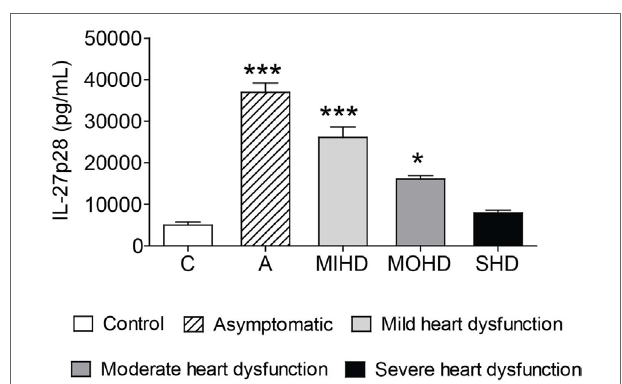
FigUre 9 | Increased serum levels of IL-27 are related to milder clinical forms of chronic chagasic cardiomyopathy. IL-27p28 was measured in the sera of control individuals, patients with indeterminate form, or patients with mild, moderate, or severe heart dysfunction stratified by clinical evaluation and criteria for Chagas disease further specified in the Section “Materials and Methods.” These data are expressed as mean ± SEM ( P < 0.05).